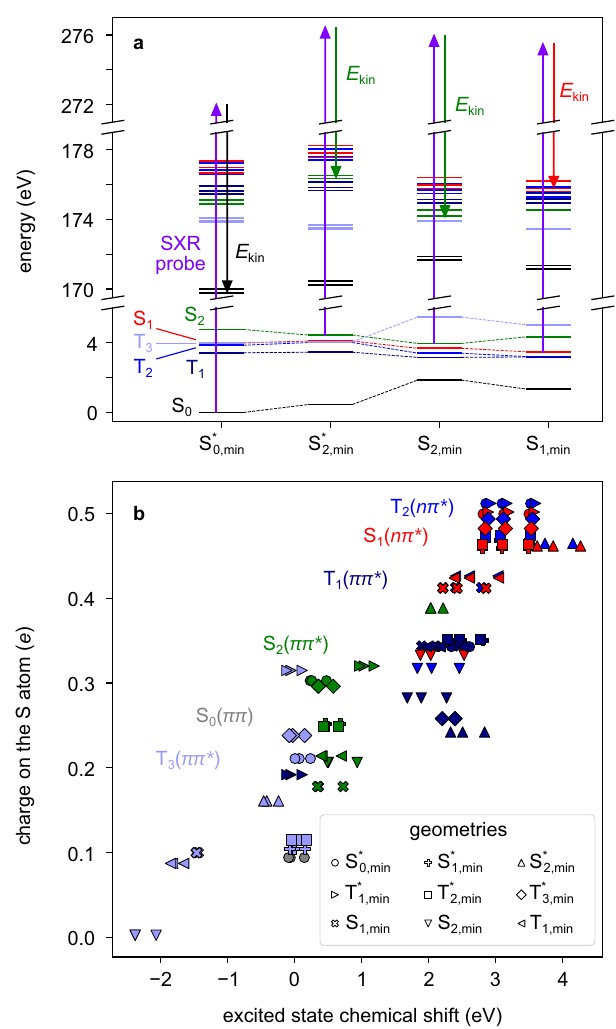
Fig. 4 Soft x-ray photoelectron probing of the excited-state dynamics of 2-thiouracil in a multi-electron picture. a Calculated electronic energies of the valence excited states, in the range 0 – 6 eV, and the core ionised states, in the range of 170 – 179 eV, for four geometries relevant in the short time dynamics. The arrows illustrate the 2 p − 1 ionisation process associated with the most intense transition. The core ionised states are grouped into sets of three states, which follow the colour coding of the valence states, meaning that their valence con fi guration is maintained with a 2 p x , 2 p y or 2 p z core hole. Accordingly, the electron kinetic energy E kin refers to ionisations out of S 0 , S 1 ( n π * ) and S 2 ( ππ * ), depending on the geometry. b Partial charges on the S atom are plotted against the excited state chemical shift of the 2 p electrons, calculated for the valence states at nine different geometries. For each geometry, the graph includes three markers for each excited state (S 1 , S 2 , T 1 , T 2 , T 3 ); in addition, three dots are included for the ionisation from S 0 at S * 0,min , for a total of 9 × 3 × 5 + 3 = 138 markers. Asterisks denote restriction in the calculation of the states to planar geometries. Source Data are provided as a Source Data fi